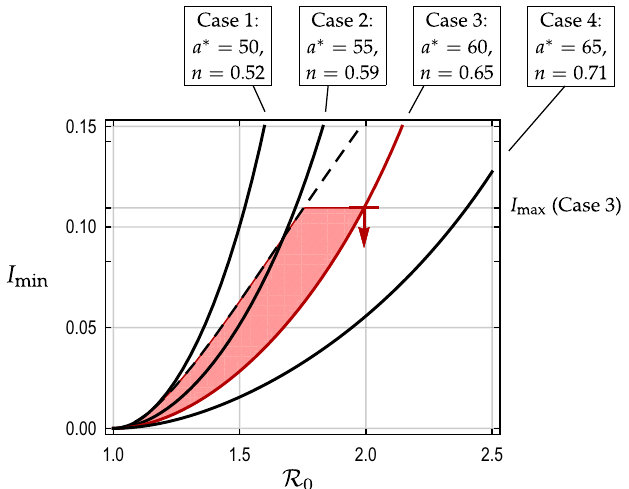
Figure 3. solid black curves show I min for Cases 1 to 4. The dashed black curve shows I peak . The marker indicates I max for Case 3, below which the proposed control scheme is feasible in terms of the healthcare system capacity. In Case 3, the proposed control scheme is feasible when R 0 and I c lie in the shaded region. The feasibility condition (7) is thus satisfied for R 0 ≤ 2.0 in Case